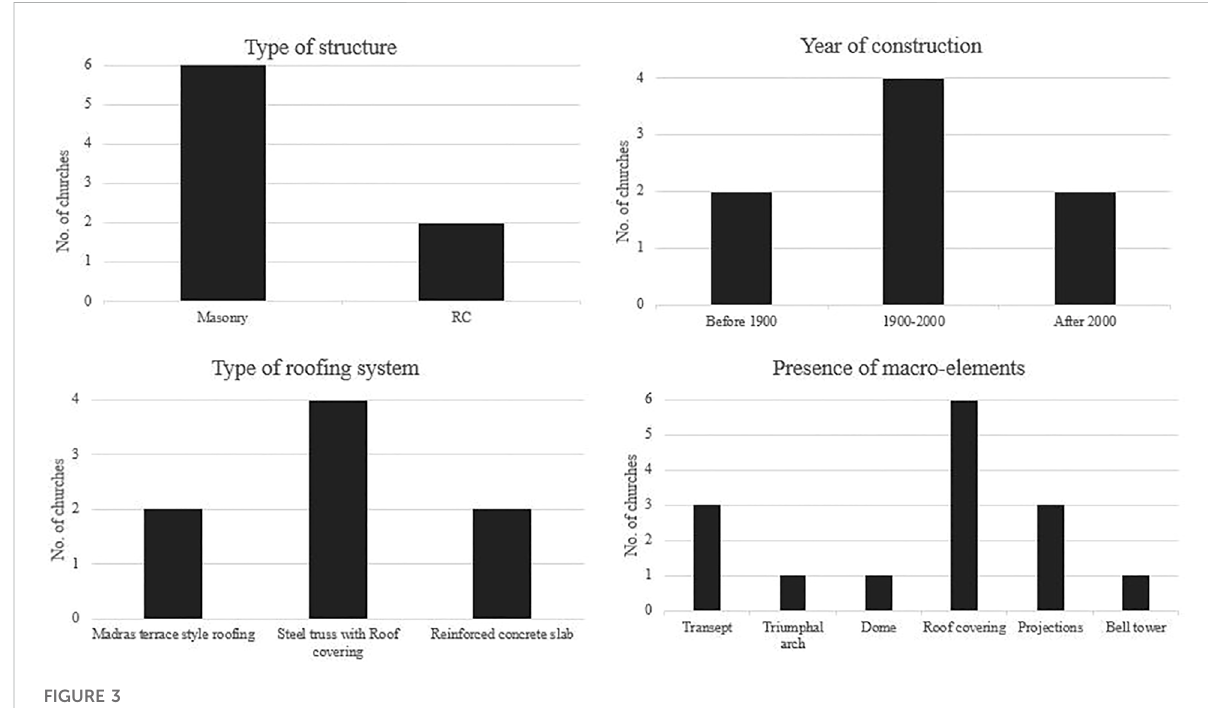
FIGURE 3 Analysis of surveyed church data.